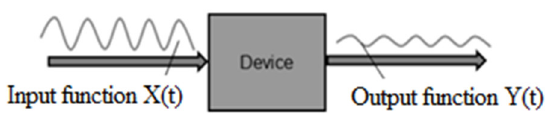
Figure 5. The principle of transfer function definition.